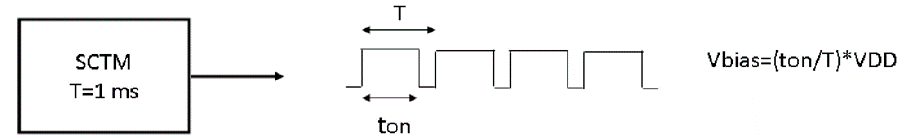
Figure 12. Amperometric circuit bias voltage, generated by an adjustable pulse width modulation (PWM) signal.